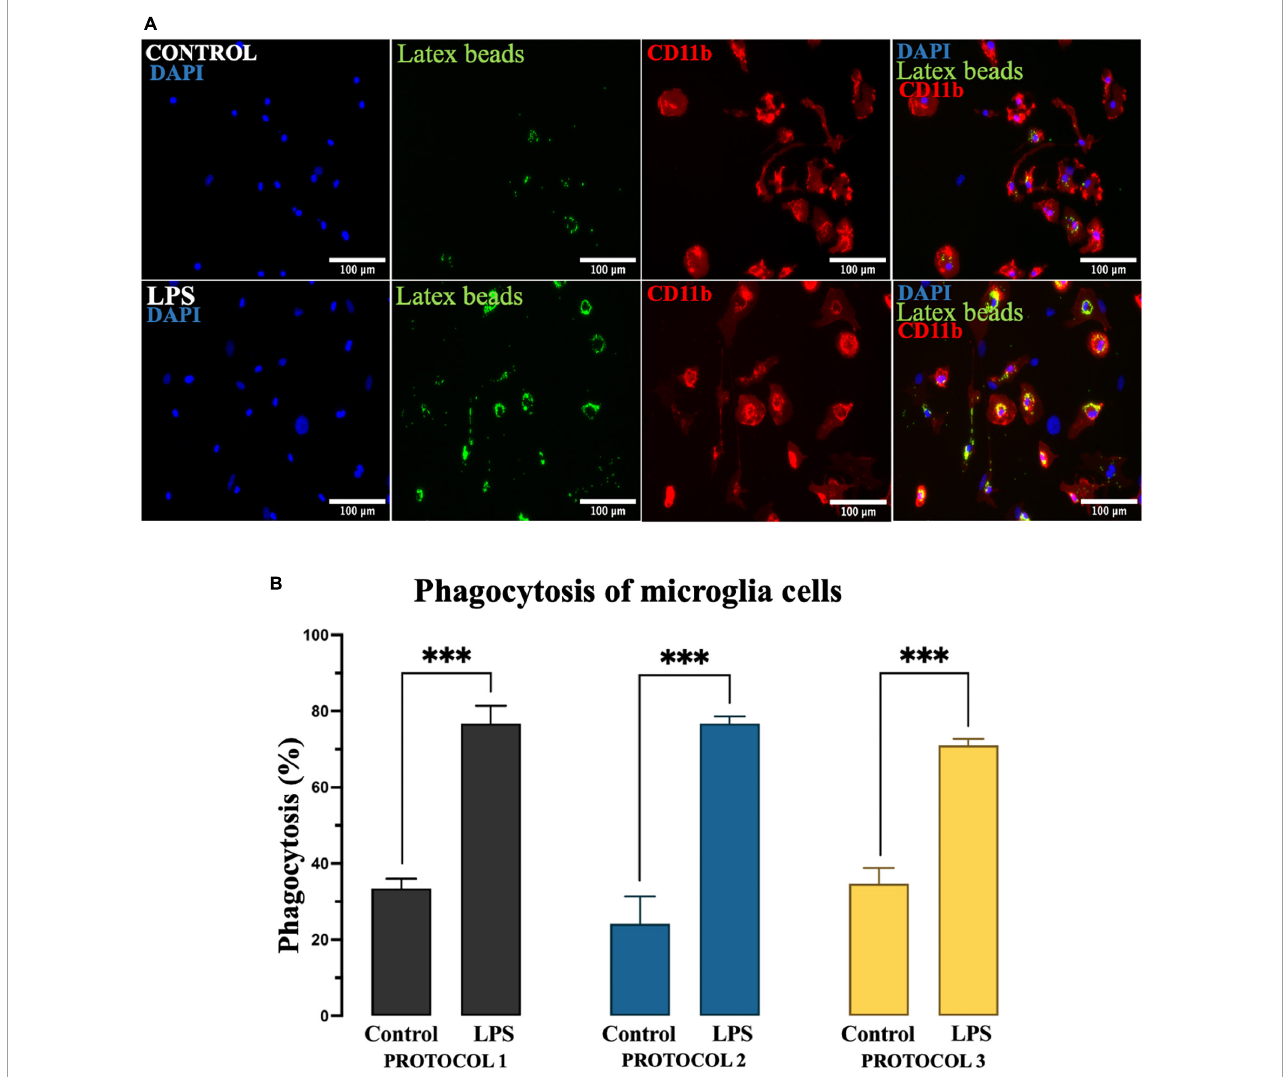
FIGURE8 Evaluation of the phagocytic activity of microglia. (A) Representative image of microglia incubated with fluorescent latex beads (green), immunolabeled for CD11b to identify the cell soma (red), and nuclei stained with DAPI (blue). Scale bar: 100 µ m. (B) The percentage of microglia involved in phagocytosis as the mean of cells that ingested at least 10 beads. Data are presented as mean ± SEM of the percentage of CD11b + latex beads + cells. ∗∗∗ p <